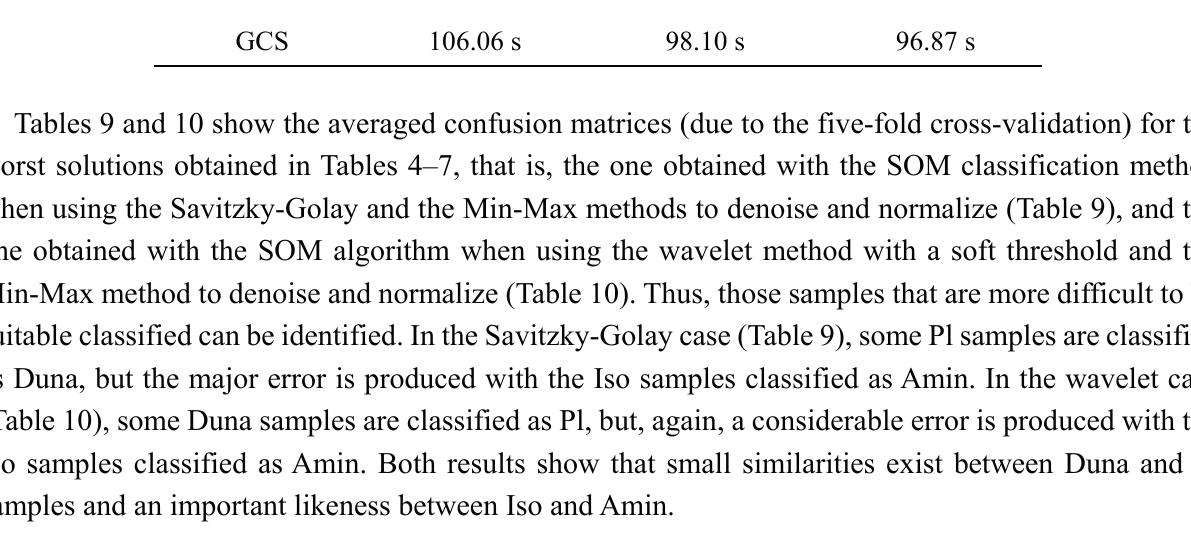
) as a denoising method (cid:2870)